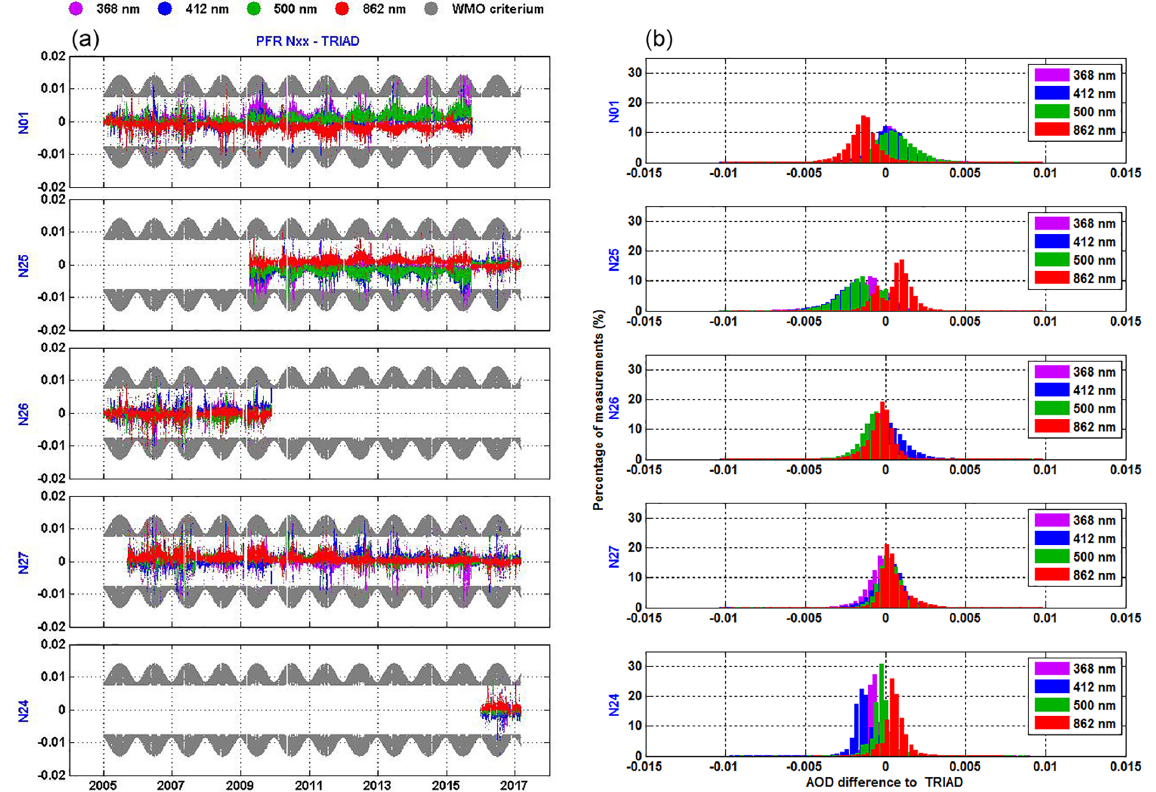
Figure 9. Correlation curves of the four PFR-measuring wavelengths. Colored points represent the data that have passed the wavelength crossing test and black ones are those that have not.